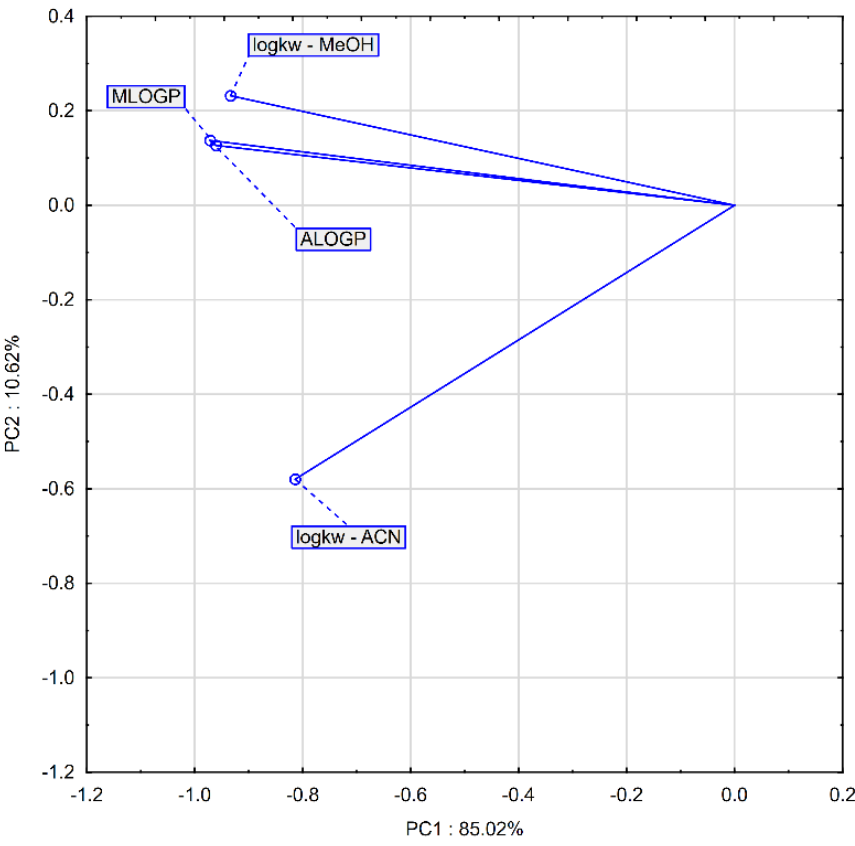
Figure 2. Projection of variables determining lipophilicity on the factor-plane.